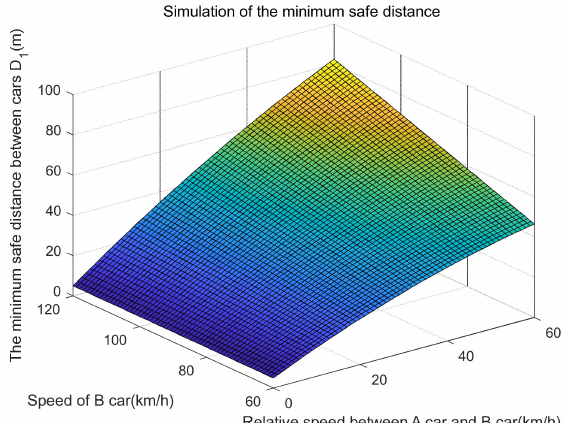
Figure 9. Changes in the minimum safe distance D 1 with various V B and V r when i = − 0.3 and d = 5.